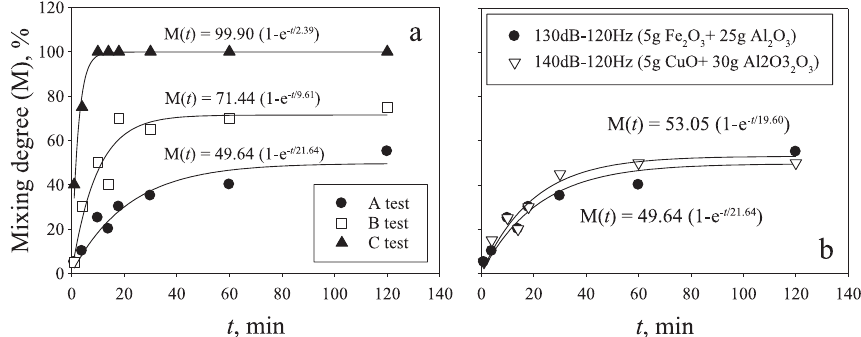
Fig. 10 (a) Time-dependence of the aggregates’ mixing degree for A, B and C mixing tests; (b) time- dependence of the aggregates’ mixing degree for Al 2 O 3 and Fe 2 O 3 A mixing test (130 dB–120 Hz; 17 wt% Fe 2 O 3 ) and for the Al 2 O 3 and CuO mixing test (140 dB–120 Hz; 14 %